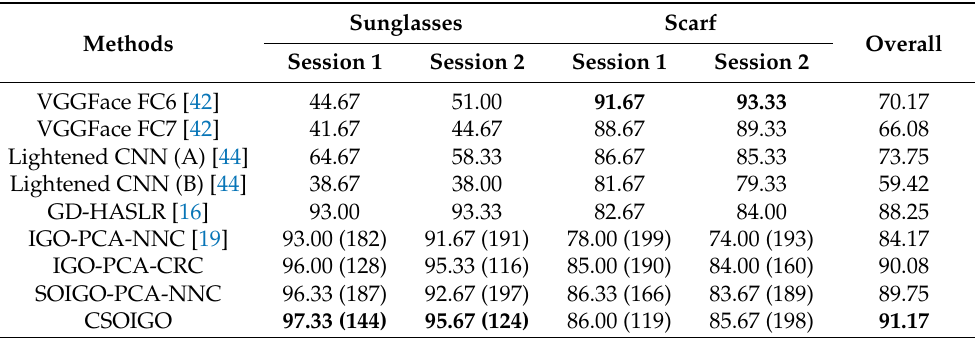
Table 4. Comparison with CNN-based approaches on a subset of the AR database (test samples contain sunglasses occlusion or scarf occlusion) when two neutral face images (from Sessions 1 and 2) per subject are used as training samples. The dimension that leads to the best result for IGO- and SOIGO-based approaches is given in